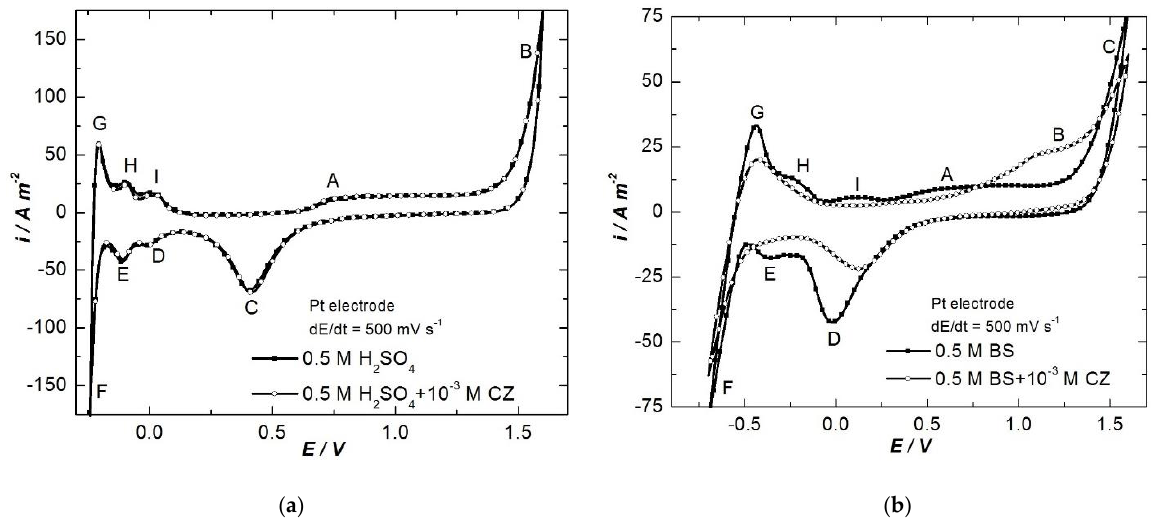
Figure 2. CVs on platinum electrode in 0.5 mol L − 1 H 2 SO 4 ( a ) and BS ( b ) without and with 10 − 3 mol L − 1 CZ, at 500 mV s − 1 scan rate.